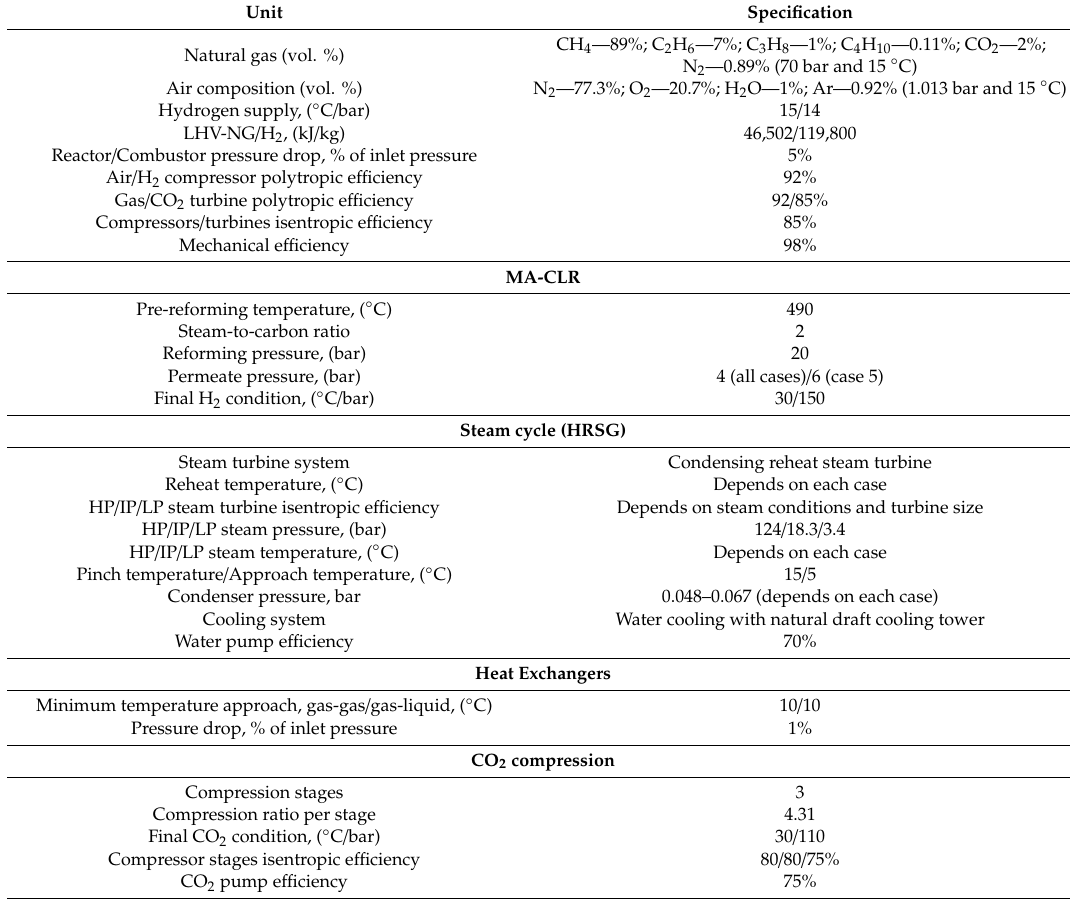
Table 1. Plant specifications and main